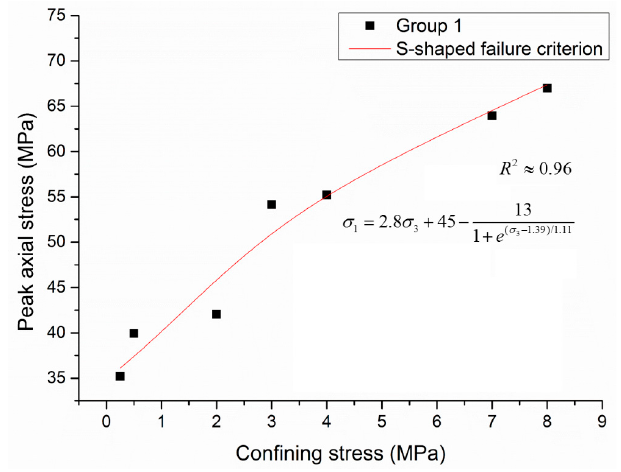
Figure 13. Strength property for S-shaped failure criterion based on the peak axial stress at failure.